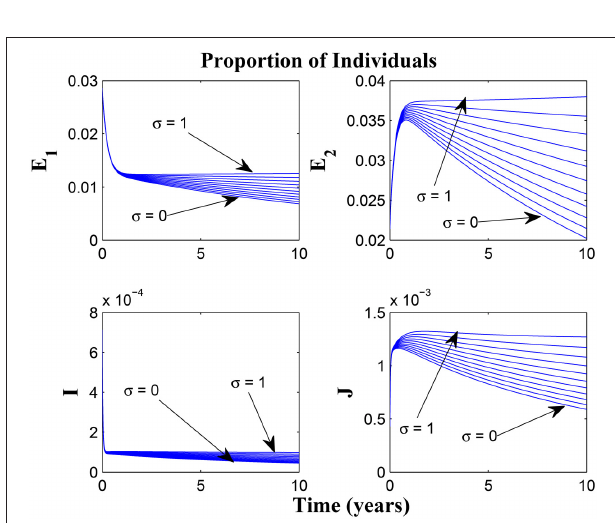
FIGURE 14 | Simulations of model (3) showing the number of infected individuals. Here, the reduced likelihood of infection due to awareness ( σ ) is varied from 0 to 1 with α 1 = α 2 = 5 , θ 1 = θ 2 = 1 and ψ = 30 .